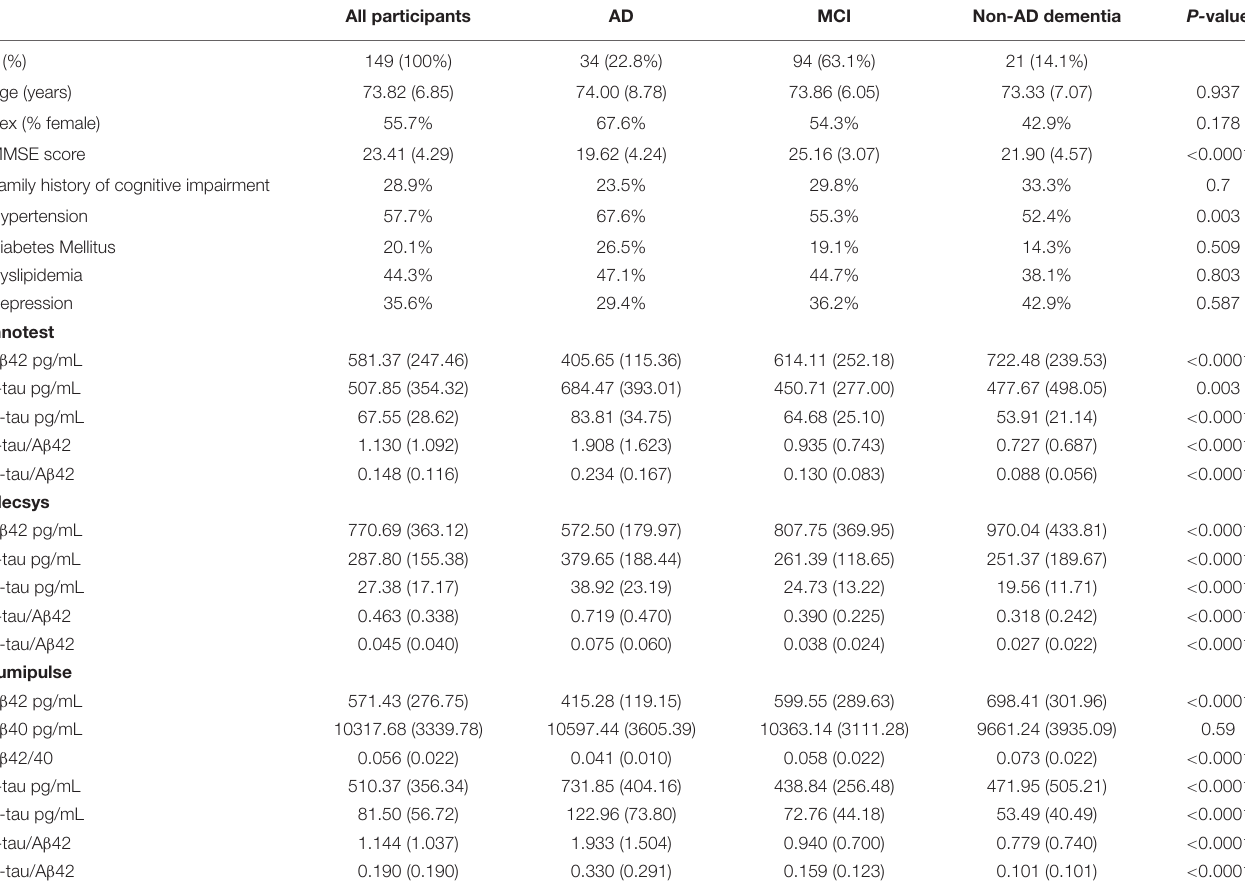
TABLE 1 | The demographic characteristics and biomarker results for AD, MCI, and non-AD patients. All participants AD MCI Non-AD dementia P-